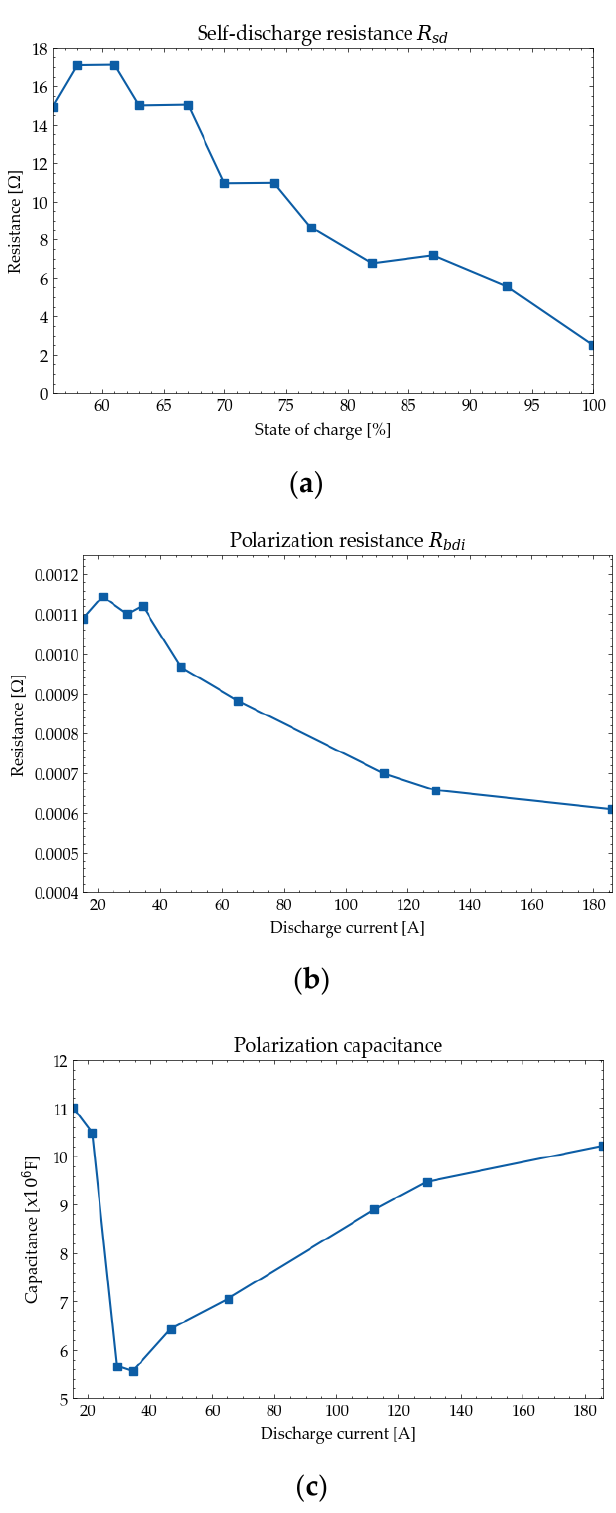
Figure 6. One-dimensional look-up tables for OPzS battery cell equivalent circuit: ( a ) Self-discharge